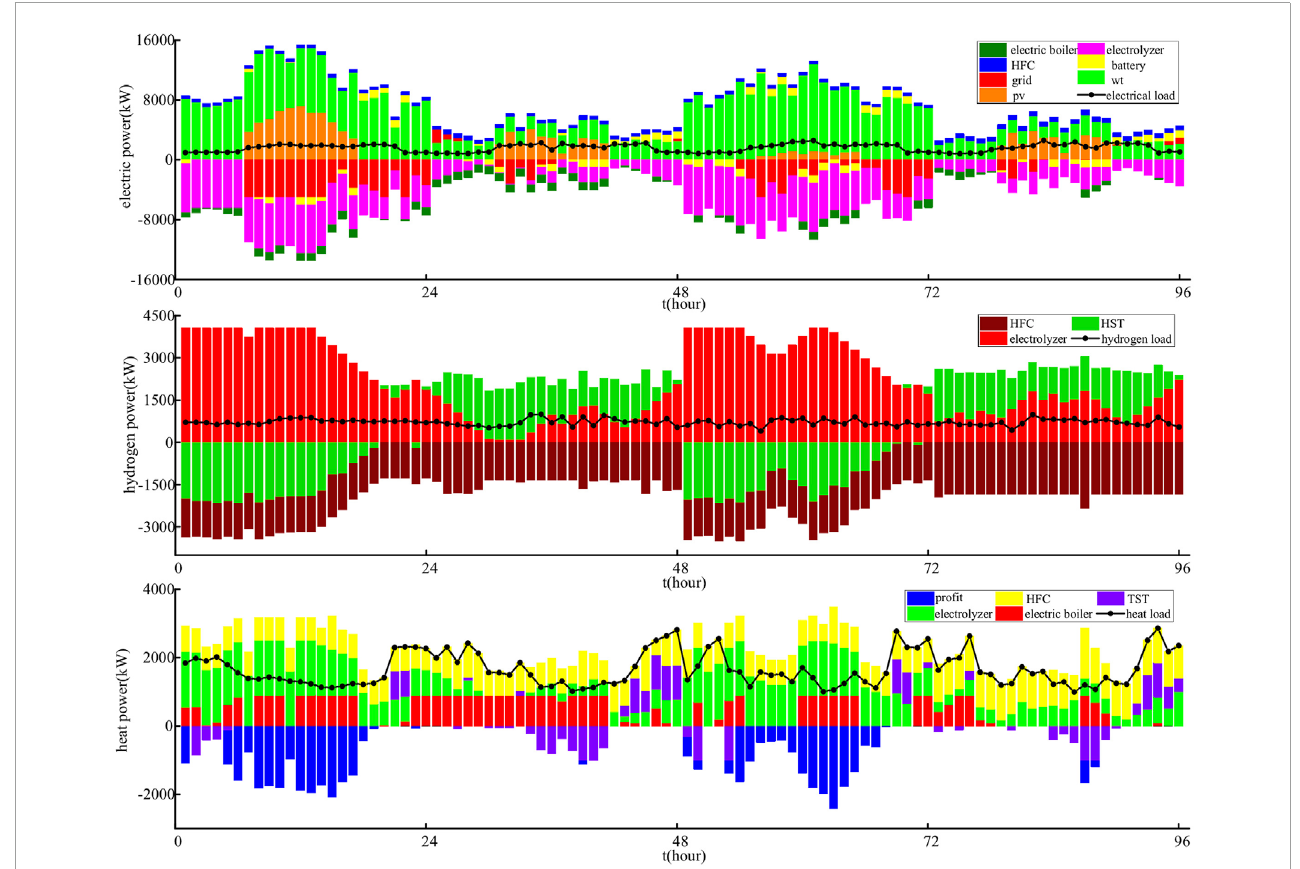
FIGURE 11 Power balance of different energy sources in case